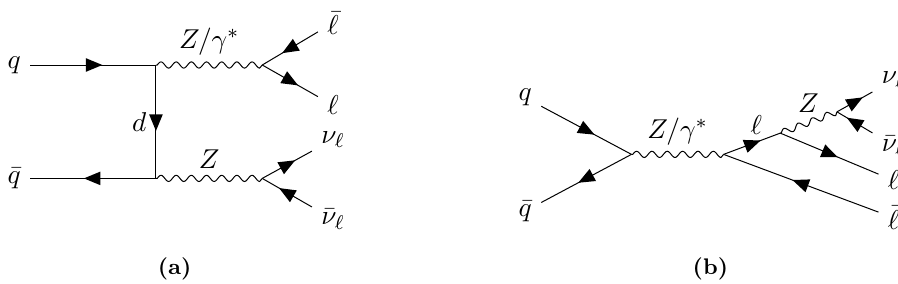
Figure 2. Sample additional LO diagrams appearing in the same-flavour channel ‘ + (cid:23) ‘ ‘ (cid:0) (cid:22) (cid:23) ‘ for (a) t -channel ZZ production, and (b) DY-type